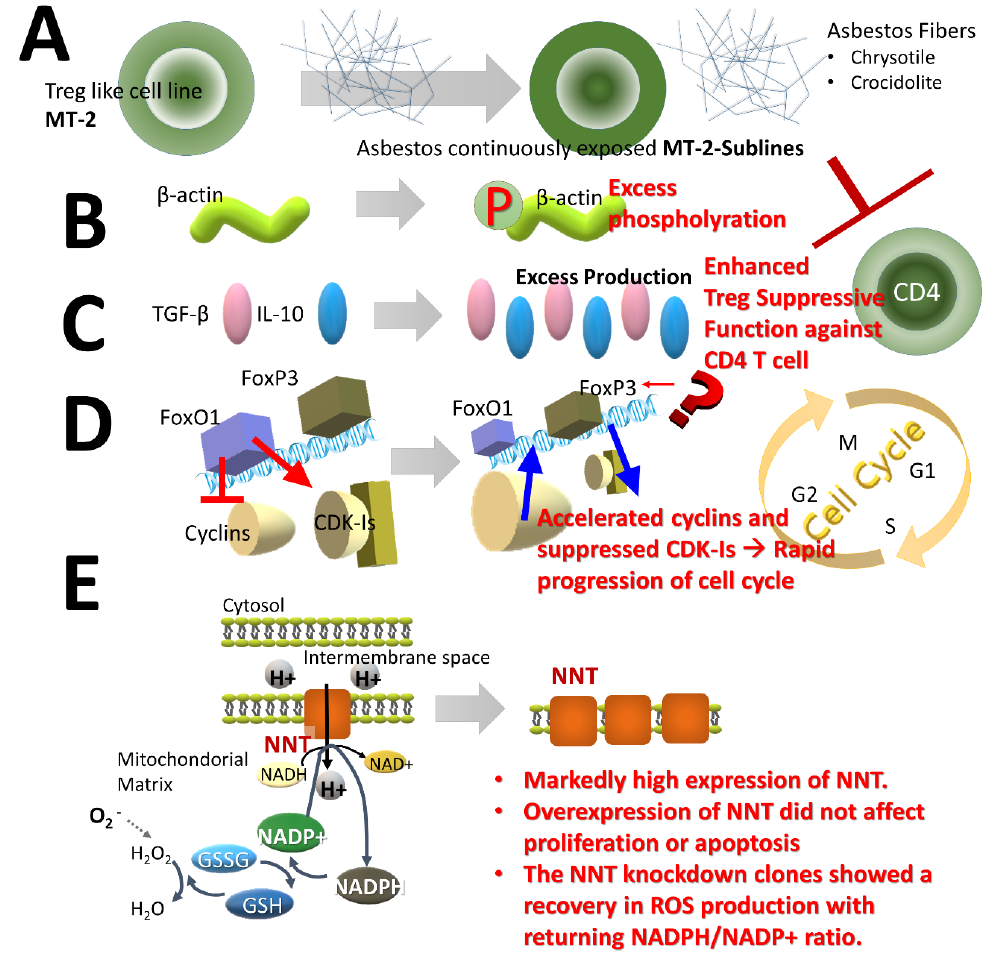
Figure 3. Summary of the effect of asbestos on Treg cells using the Treg-like cell line MT-2. ( A ) The MT-2 line resists apoptosis after continuous exposure for as long as one year at a concentration of asbestos fibers (chrysotile or crocidolite) that induces apoptosis in less than half the cell population following transient exposure. Sublines that acquired resistance to apoptosis were established. ( B ) In terms of protein expression, excessive phosphorylation of β -actin occurred in sublines. ( C ) Cytokines cause overproduction of IL-10 and transforming growth factor (TGF)- β , which are soluble factors required for expression of typical Treg cell function, together with cell–cell contact, and functional enhancement was shown. ( D ) Among the transcription factors, forkhead box protein O1 (FoxO1) was significantly attenuated, and negative regulation of cyclins with positive regulation of cyclin-dependent kinase-inhibitors (CDK-Is) accelerated the cell cycle. Asbestos-exposed Treg cells were over-functional and abundant. Expression of FoxP3, an important Treg cell transcription factor, was slightly attenuated in spite of hyperactivity, although no other significant changes such as methylation were observed. ( E ) Furthermore, nicotinamide nucleotide transhydrogenase (NNT) was highly expressed due to the relationship between oxidative stress and oxidative phosphorylation. This may act to protect asbestos-exposed Treg cells from oxidative stress and may also play a role in their escape from cell death.